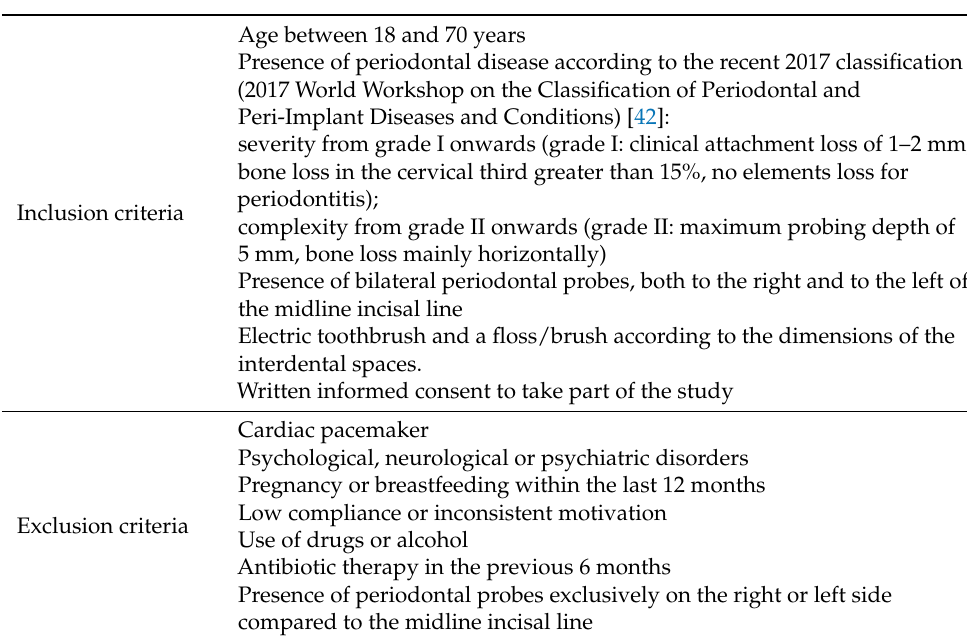
Table 6. Inclusion and exclusion criteria.